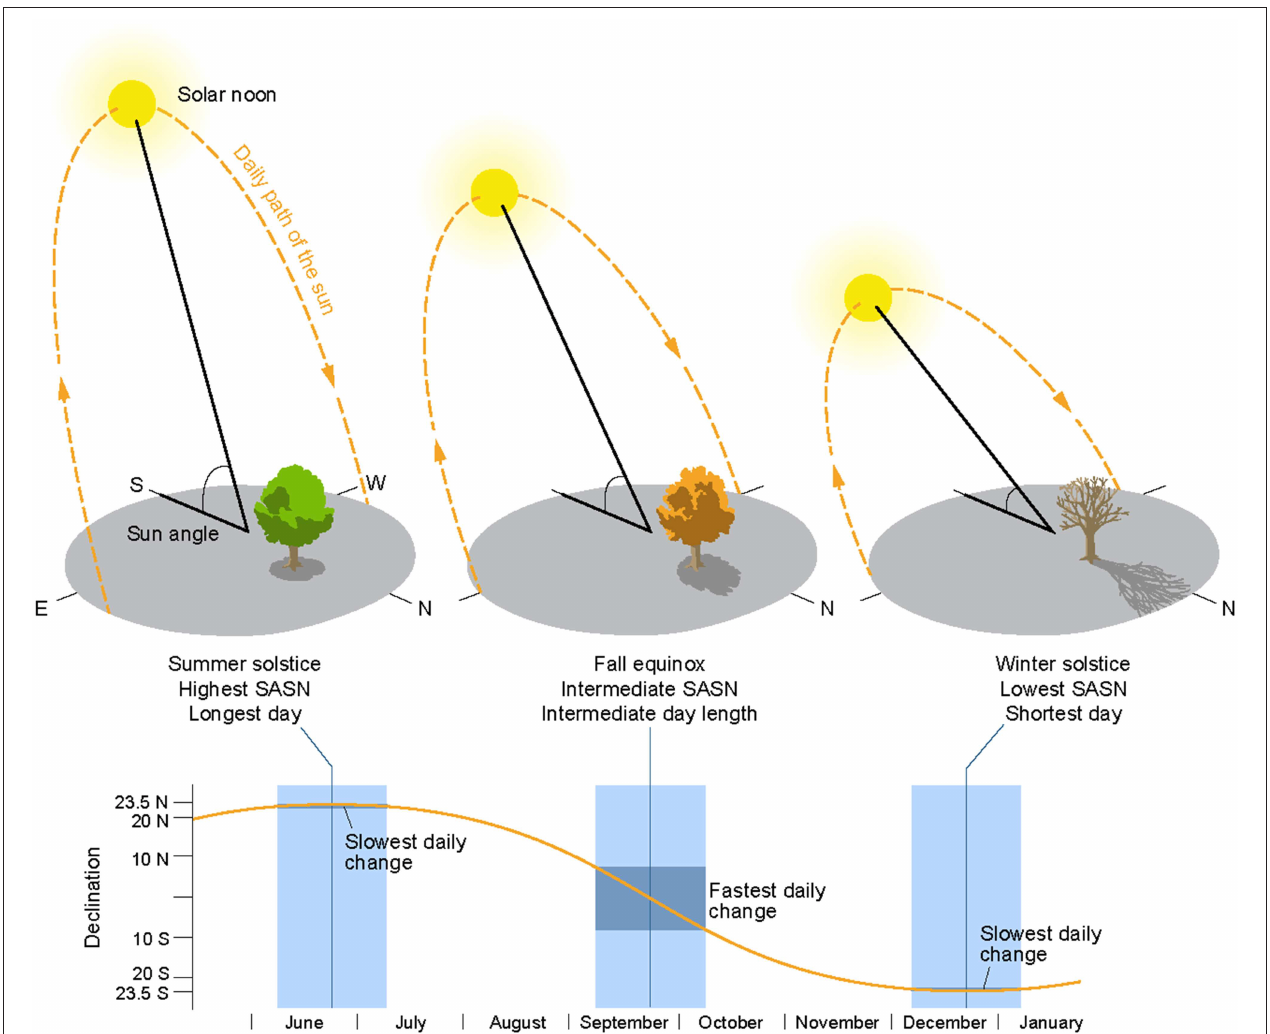
FIGURE 1 | Sun angle at solar noon (SASN). SASN is the vertical angle of the sun above the horizon at the daily midpoint between sunrise and sunset (solar noon) as the sun traverses the sky from east to west. SASN is affected by the earth’s tilt toward the sun (declination) and the latitude of observation. The graphs illustrate how declination changes during the fall migration—a slow, then fast, then slow rate of day-to-day